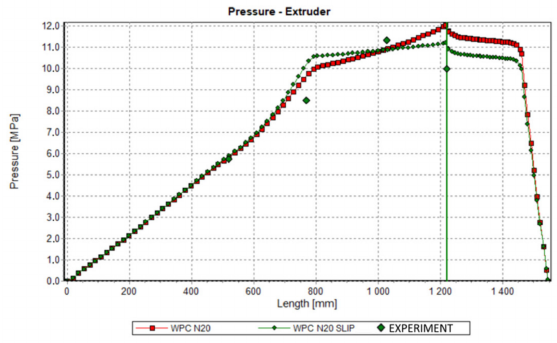
Figure 15. Validation of simulation: Pressure profile, N = 20